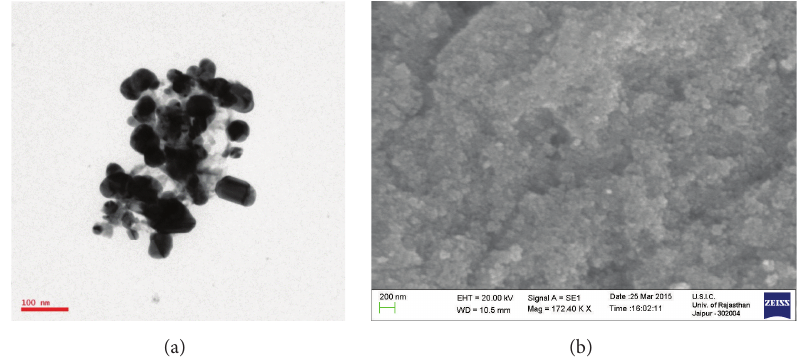
Figure 4: (a) The SEM images and (b) TEM image of AgNPs synthesised by cell-free extracts of S. platensis